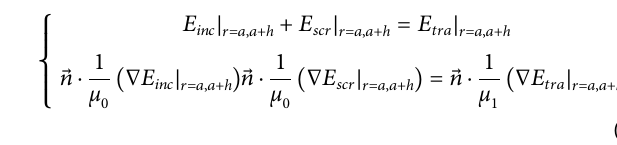
FIGURE 1 | Schematic diagram of the model. The core cylinder is the fi ber optical nanoprobe to be cloaked. The cloak is composed of the two layers A and B with different optical parameters. a = 201.43 nm, and b = 322.28